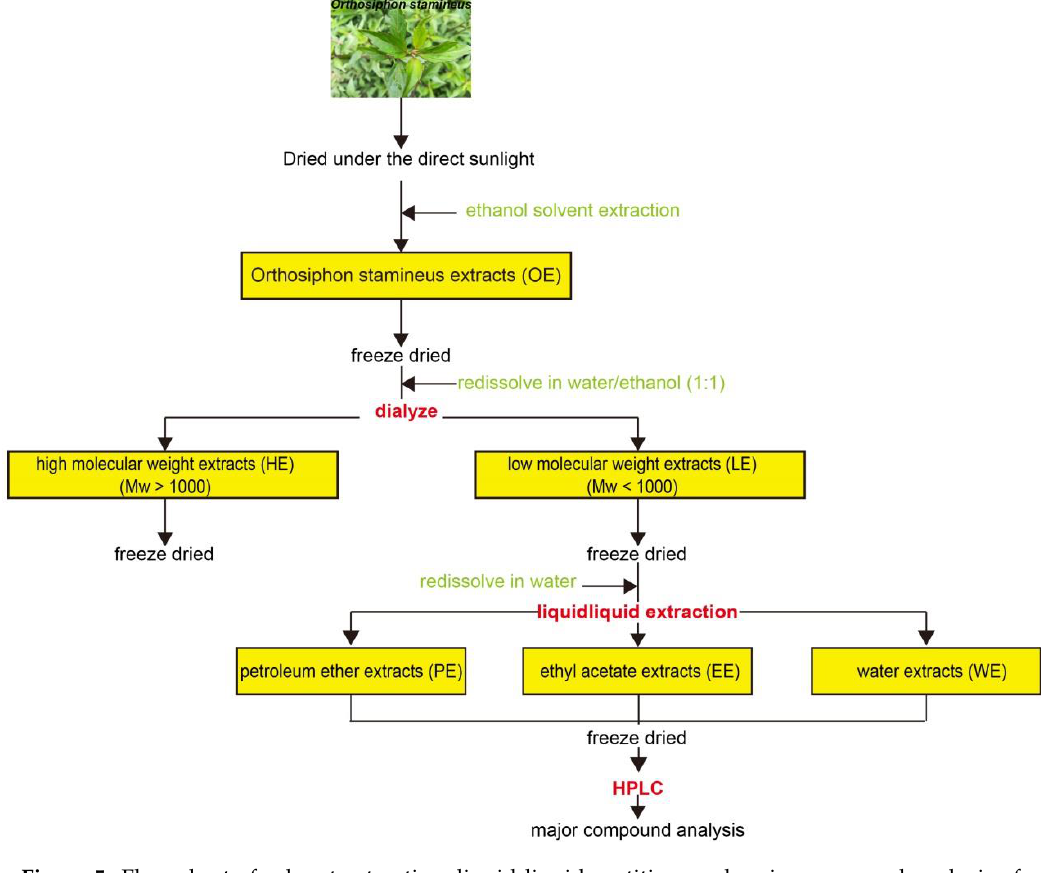
Figure 5. Flow chart of solvent extraction, liquid-liquid partition, and main compound analysis of Orthosiphon stamineus